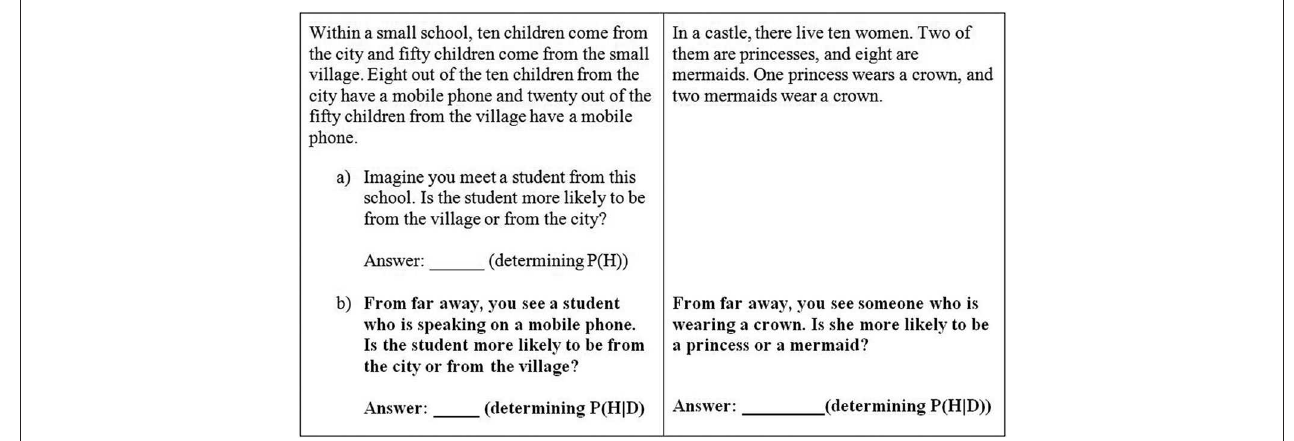
FIGURE 4 | On the left: “Guided” task ( FEU ); on the right: “Non-guided” task ( LaH ).